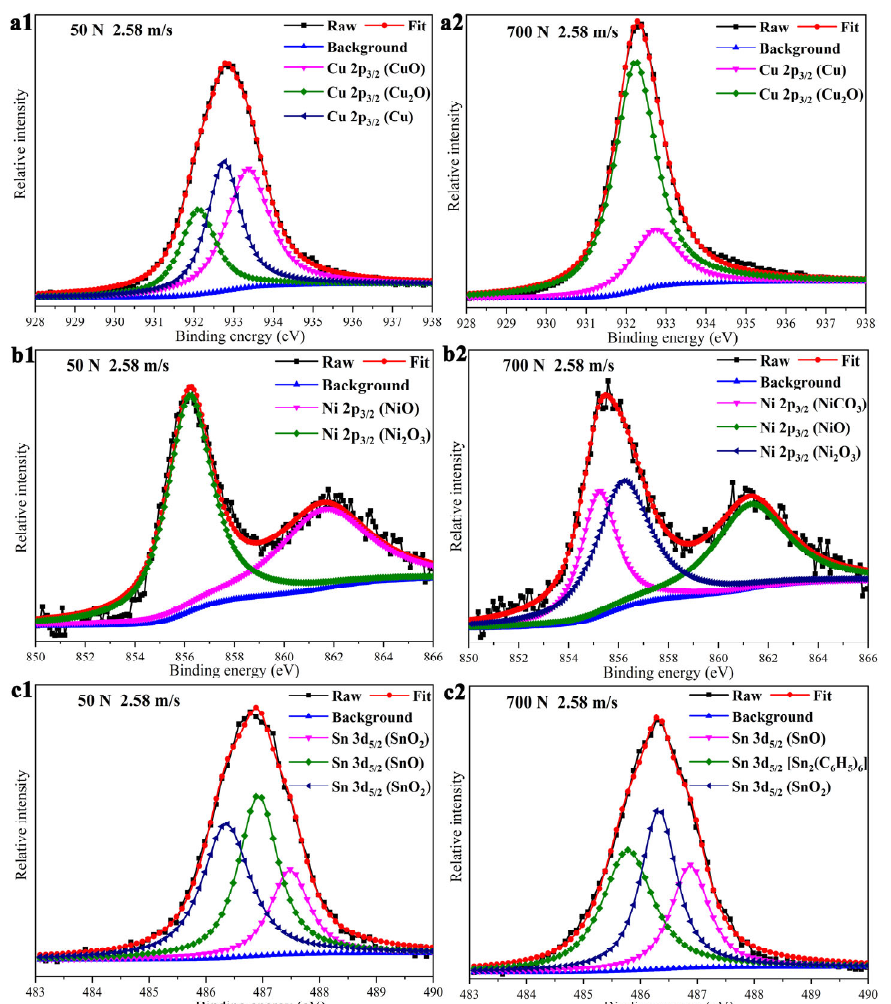
Fig. 12 Cu 2p, Ni 2p, and Sn 3d spectra of the worn tracks on Cu ‒ 15Ni 8Sn 0.8Nb alloy under different sliding conditions ‒ ‒ using the XPS peak-fitting